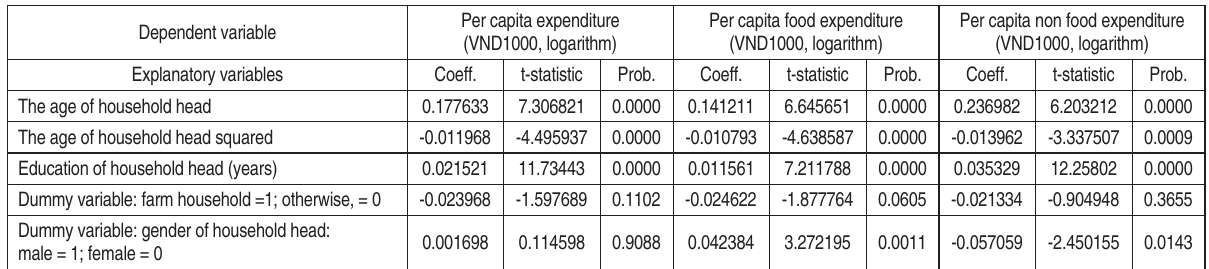
Table 4. Second stage least squares regression: effect of credit on household